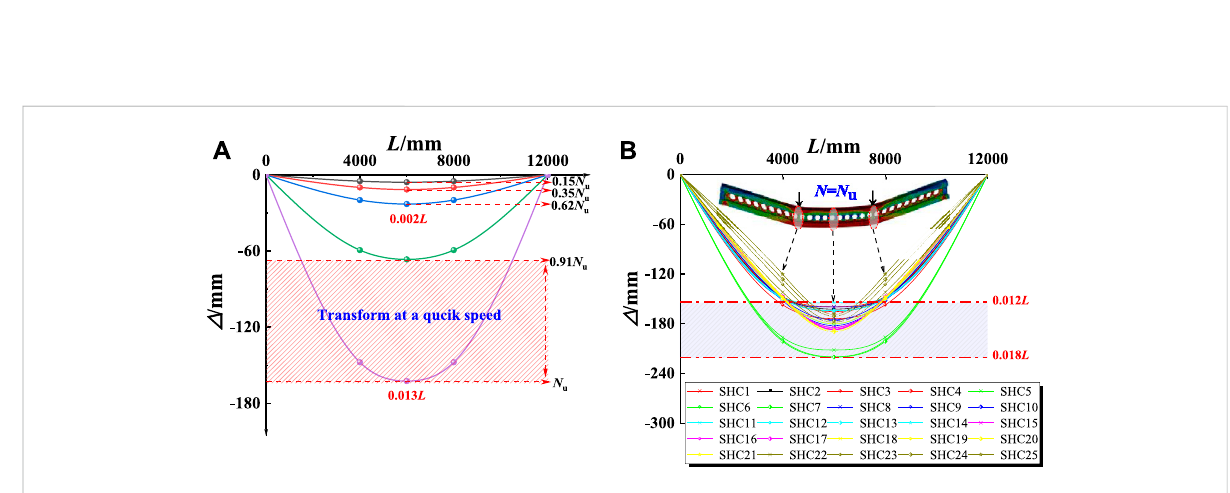
FIGURE 15 Analysis for de fl ection of SHC. (A) De fl ection distribution of SHC2 (B) De fl ection distribution of 25 specimens.